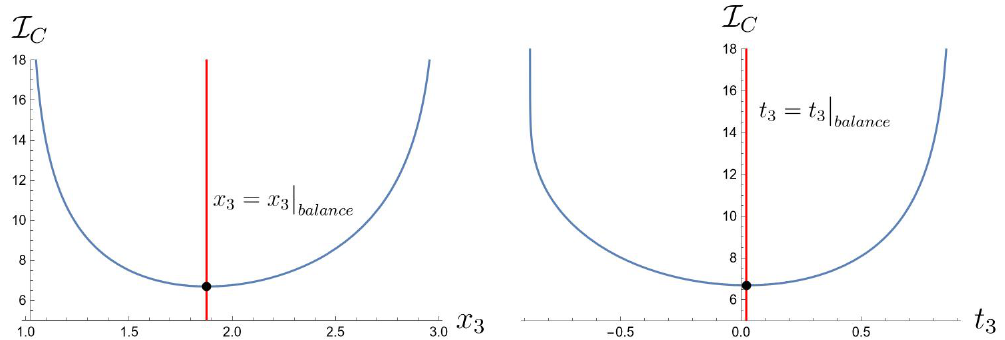
= 55, c = 37, and Figure 4: We evaluate case 1 (51) with η = 1 / 5, ¯ η = 1 / 6, c geo ano we additionally consider that the first balance requirement (50) is satisfied. In this case, the crossing PEE I is a function of x , t . We will let either x or t satisfy C 3 3 3 3 the second balance requirement (52) and see whether the saddle of I is settled C at the balance point of the other parameter. Left figure: The blue curve describes = I ( x | ) and the red vertical line corresponds to x I , t at the balance C C balance 3 3 3 = I ( x | ) and the red point. Right figure: The blue curve describes I , t C C balance 3 3 vertical line corresponds to t at the balance point. The black dot in the two figures 3 denotes the same balanced crossing PEE which is indeed the minimum point. Other cases can be verified in a similar